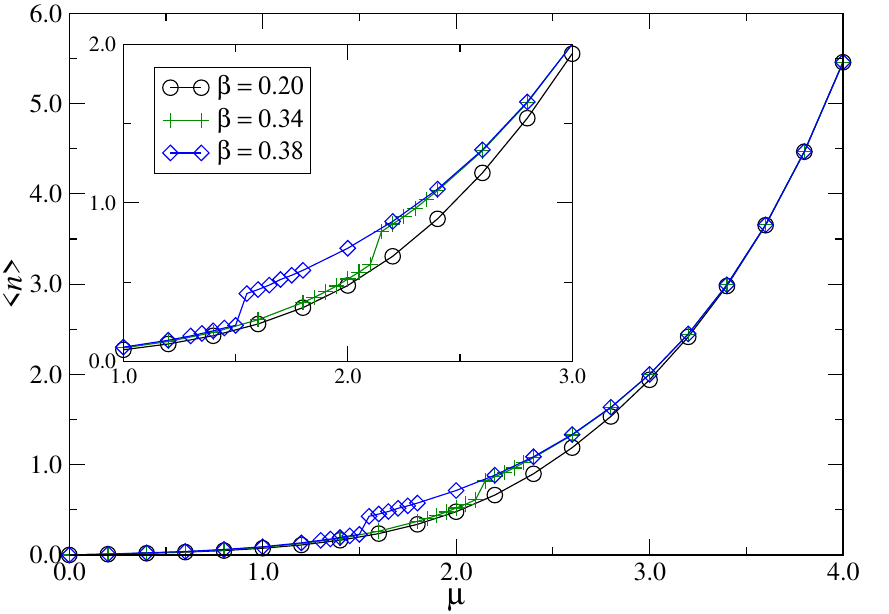
Figure 15 . µ dependence of h n i at η = 0 . 1 with β = 0 . 20 , 0 . 34 and 0 . 38 . Inset graph magnifies the vicinity of the transition points at β = 0 . 34 and 0 . 38